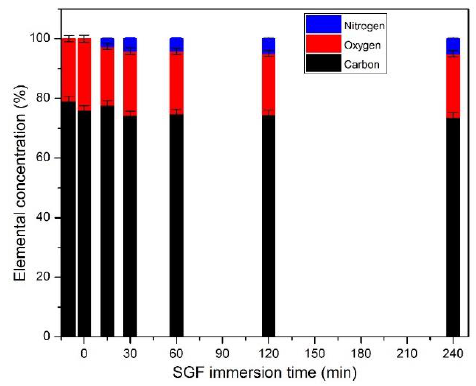
Figure 6. Dependence of the surface elemental concentration on the SGF immersion time.